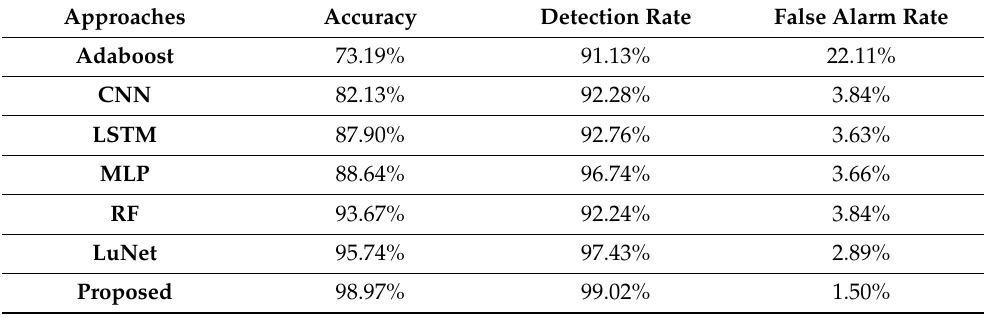
Figure 10. ( a ) FPR comparison for CICIDS-2017 dataset ( b ) FPR comparison for UNSW-NB15 da- taset.